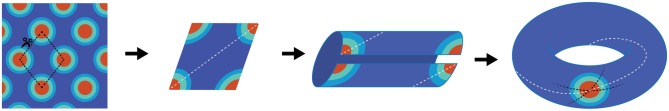
Schematic depiction of why grid cells map to a torus. The far left panel is cartoon depiction of a grid cell’s firing pattern in a two-dimensional environment. Making a cut through the center of four fields provides a diamond shape (second panel), which comprises the base unit. The dashed white line illustrates running the “long distance” in the diamond between the furthest two fields. By connecting the bottom edge to the top edge, two “half-fields” are generated (third panel) which becomes a single field when connecting the opened ends (far right panel). Note that there are three lines on the completed torus. The dashed black lines represent the original cuts along made in the first panel. The white line resembles the trajectory necessary to connect the two furthest points in the diamond. Note that it makes one revolution per rotation. That is, the trajectory travels through the interior of the tours as well as along the exterior.